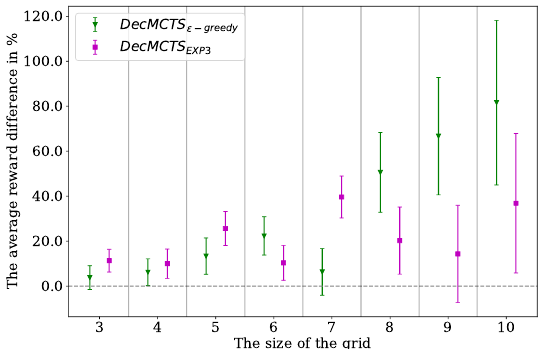
Figure 10. The average cumulative reward difference in % over different grid size of meeting in grid problem. 0.0 line represents the performance of UCT . The whiskers show the standard